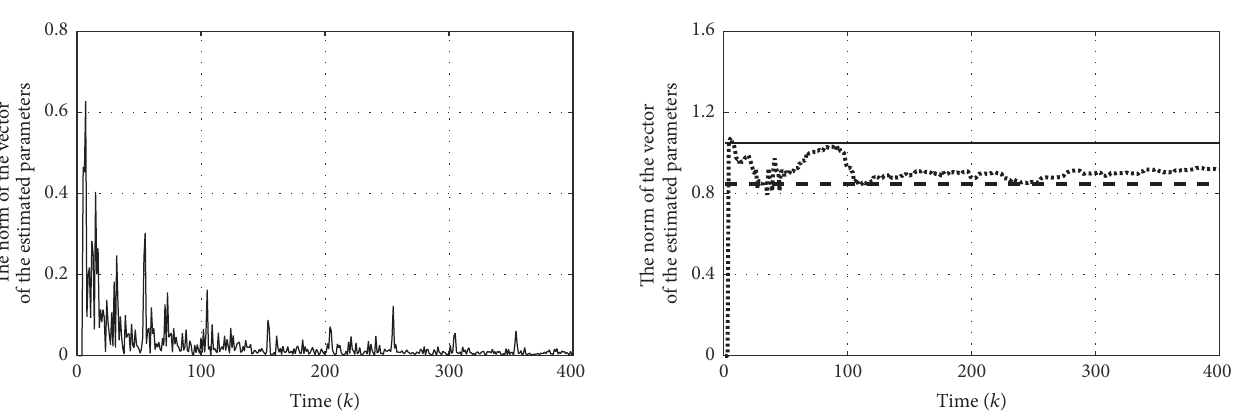
Figure 7: Evolution curve of the norm of the vector of the estimated ‖̂𝜃(𝑘)‖ parameters .